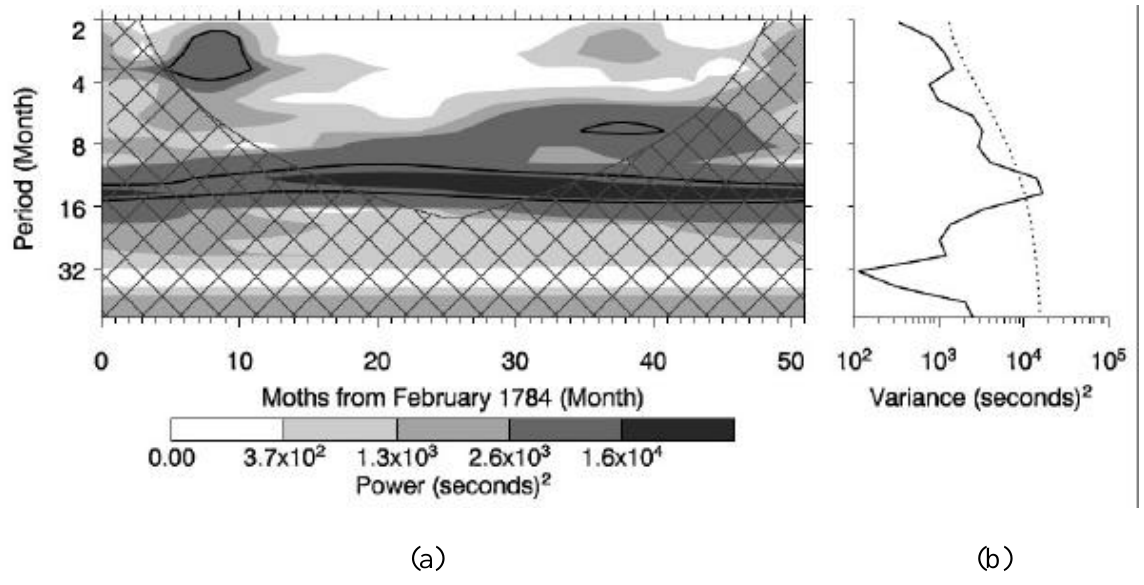
Fig. 3. (a) The wavelet power spectrum of the deviations of geomagnetic declination at 14h between February 1784 and May 1788. The contour levels are chosen so that 75%, 50%, 25%, and 5% of the wavelet power is above each level, respectively. The cross-hatched region is the cone of influence, where zero padding has reduced the variance. Black contour is the 5% significance level, using a red-noise background spectrum. (b) The global wavelet power spectrum (black line). The dashed line is the significance for the global wavelet spectrum, assuming the same significance level and background spectrum as in (b).